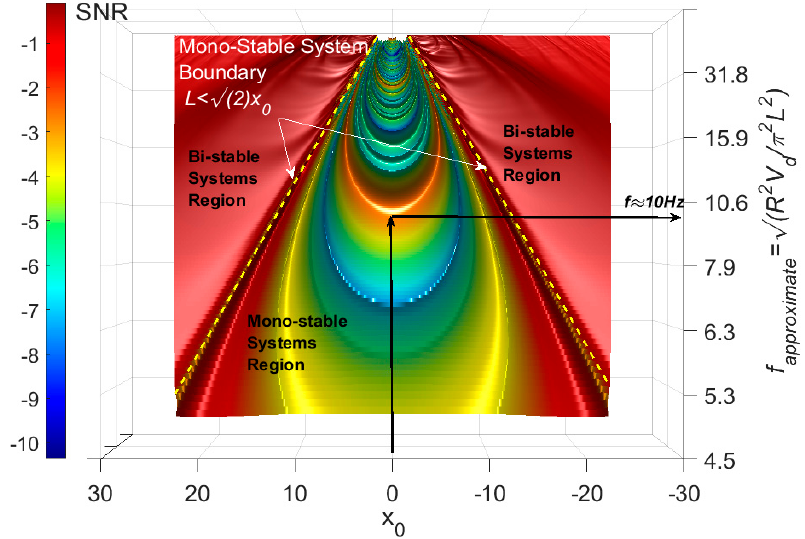
Figure 5. SNR-surface plot for the extracted signals at different potential geometries.